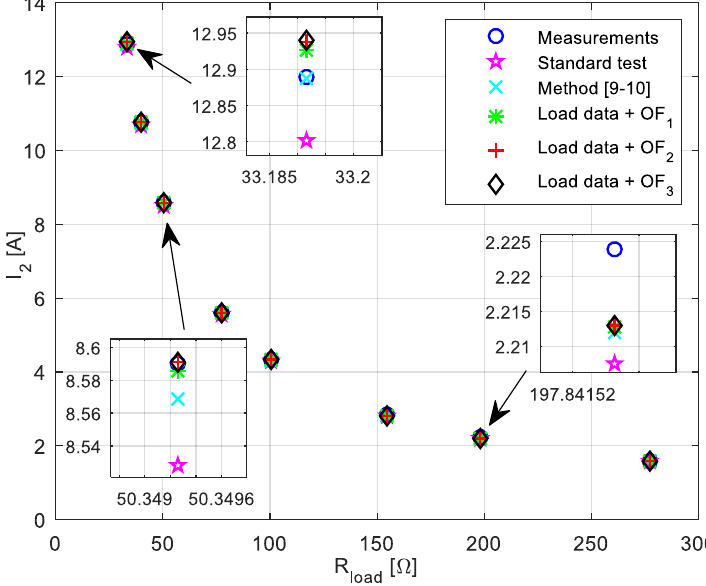
Figure 6. Secondary current versus load resistance referred to the primary side characteristics.